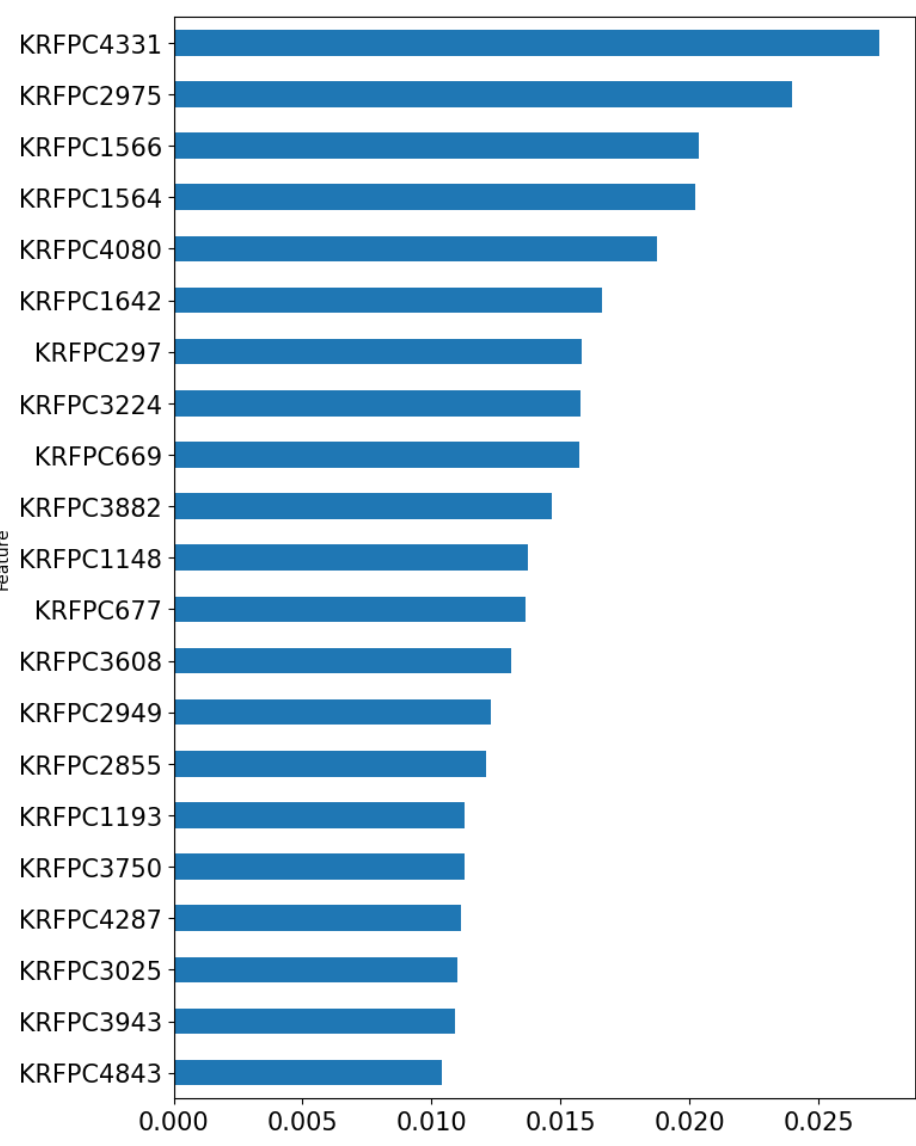
Figure 6: Bar plot of feature importance of the classification model. The top 20 KlekotaRothCount fin- gerprints are demonstrated in the horizontal bar